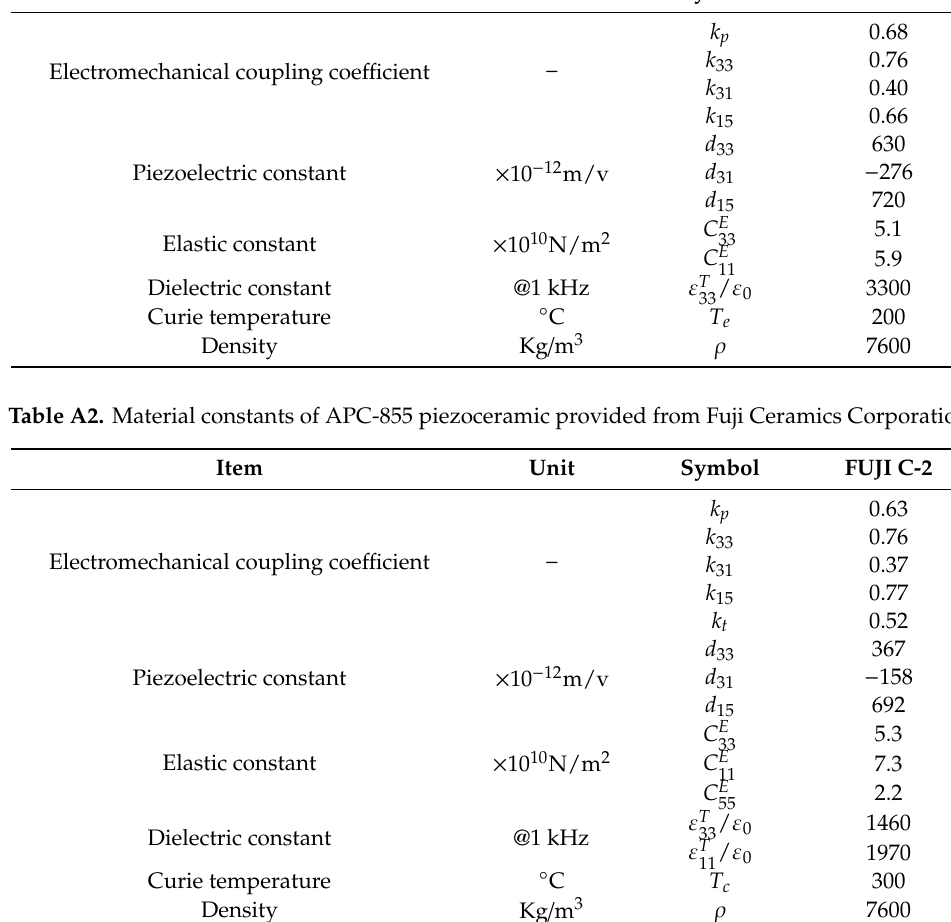
Table A1. Material constants of APC-855 piezoceramic provided from APC International, Ltd. Item